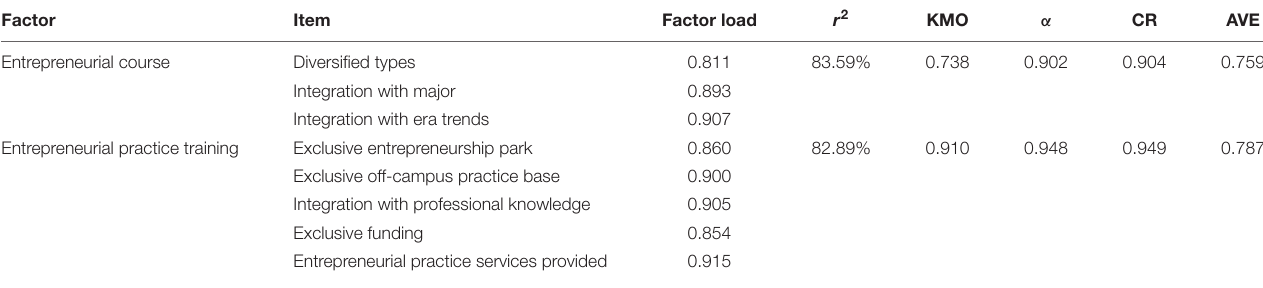
TABLE 3 | The reliability and validity of each